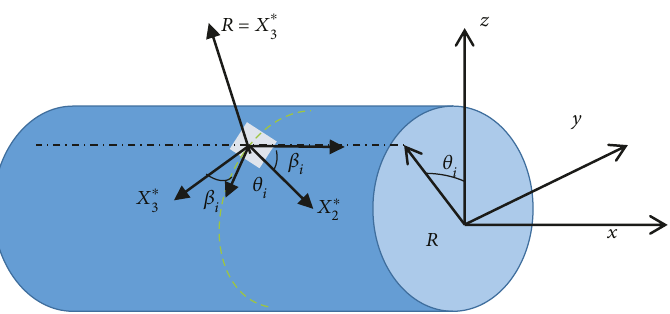
Figure 2: Location of strain gauge placed on beam